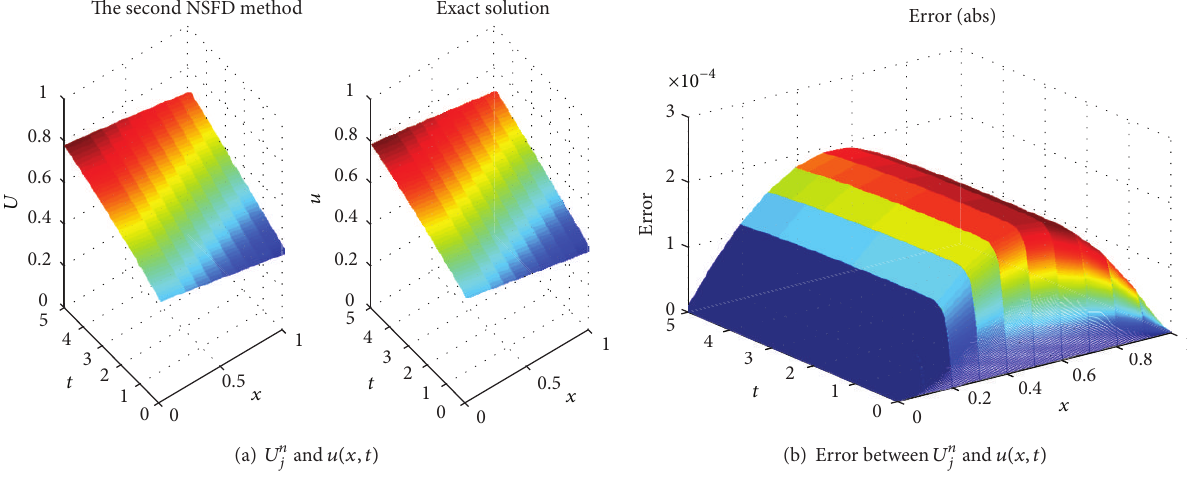
Figure 1: Simulations of NSFD scheme (34) for (4) with stepsize Δ𝑡 = 0.001 and ℎ = 0.1 .